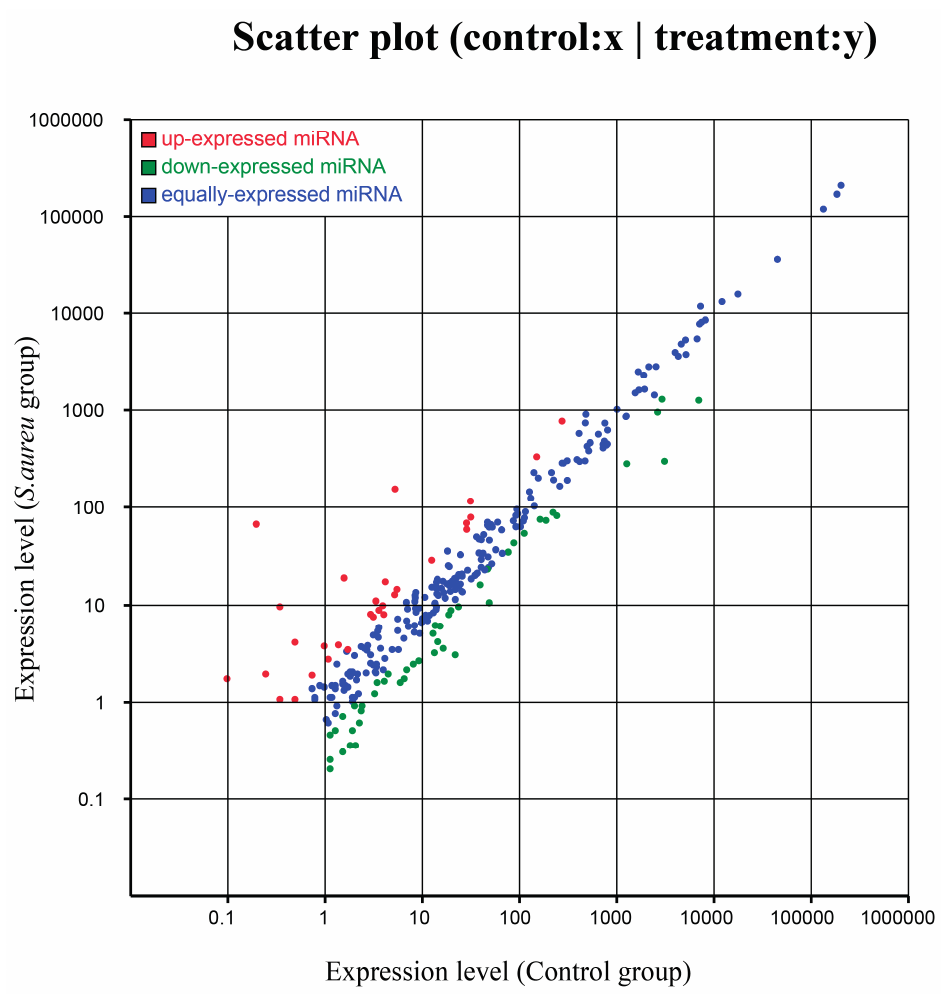
Figure 3. Differential expressions of known miRNAs in MG (Mammary Gland) between the control group and S. aureus group (red points represent miRNAs with fold change >2, blue points represent miRNAs with 0.5 < fold change ≤ 2, and green points represent miRNAs with fold change ≤